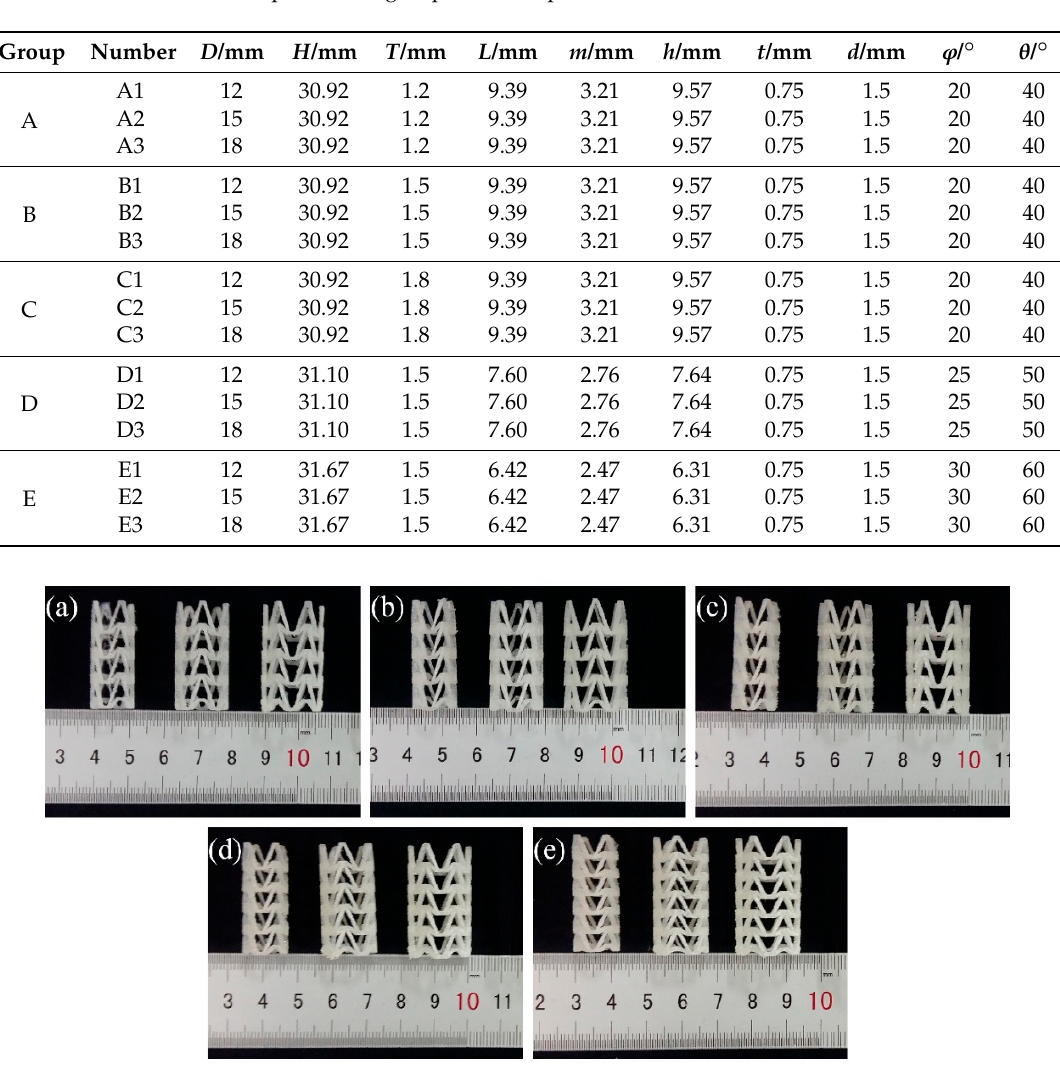
Table 1. Experimental groups and size parameters of PLA vascular stents.